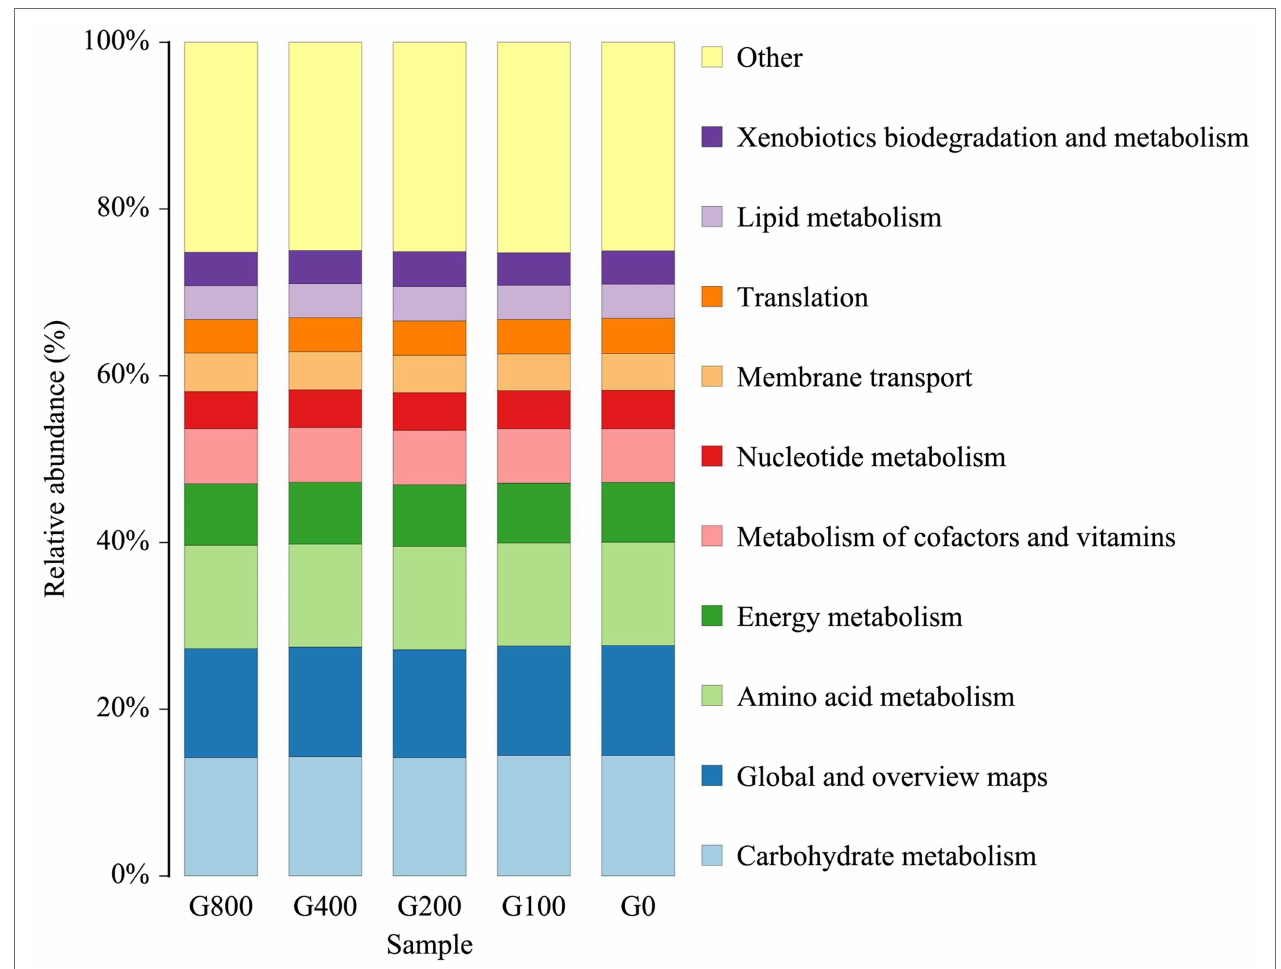
FIGURE 8 | Microbial functions in the top 10 of level-2 for intestine samples (mean ± SD, n =